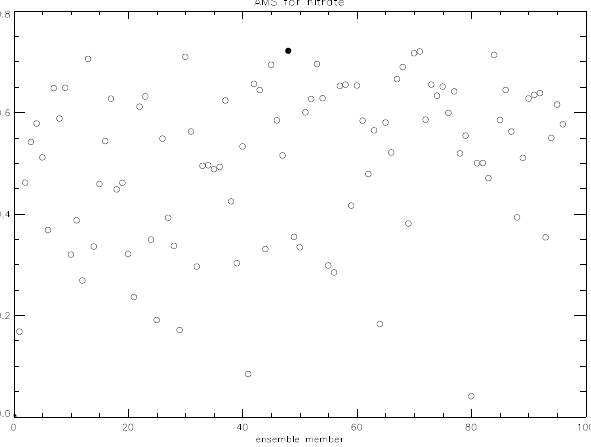
Fig. 7. The AMS for the ocean carbon cycle ensemble’s nitrate con- centration when compared against World Ocean Atlas data. The en- semble member giving rise to the highest AMS is marked with a filled